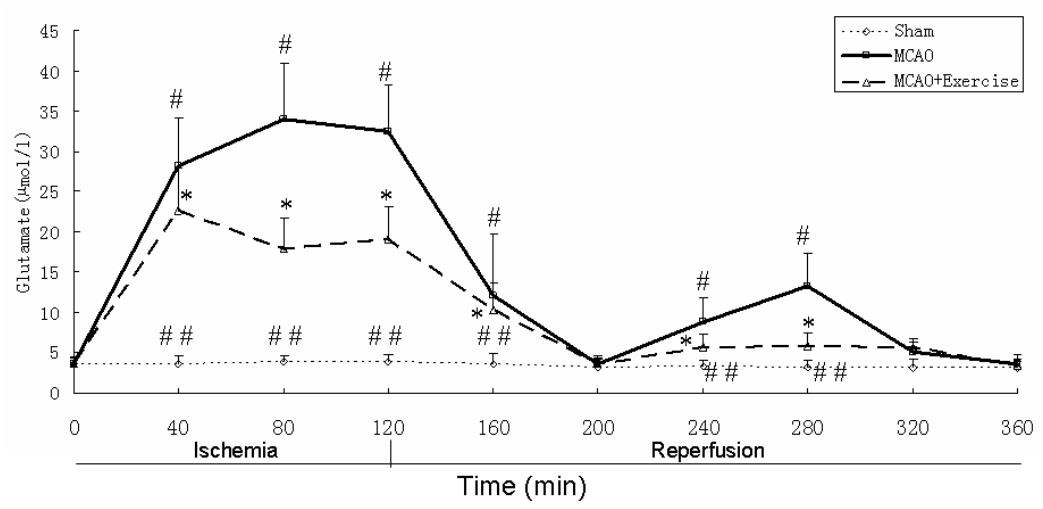
Figure 3. Striatal dialysate glutamate levels. See text for discussion. Data represent mean ± SD. # P < 0.05 relative to sham surgery at the same time point. ## P < 0.05 relative to MCAO+Exercise at the same time point.* P < 0.05 relative to MCAO at the same time